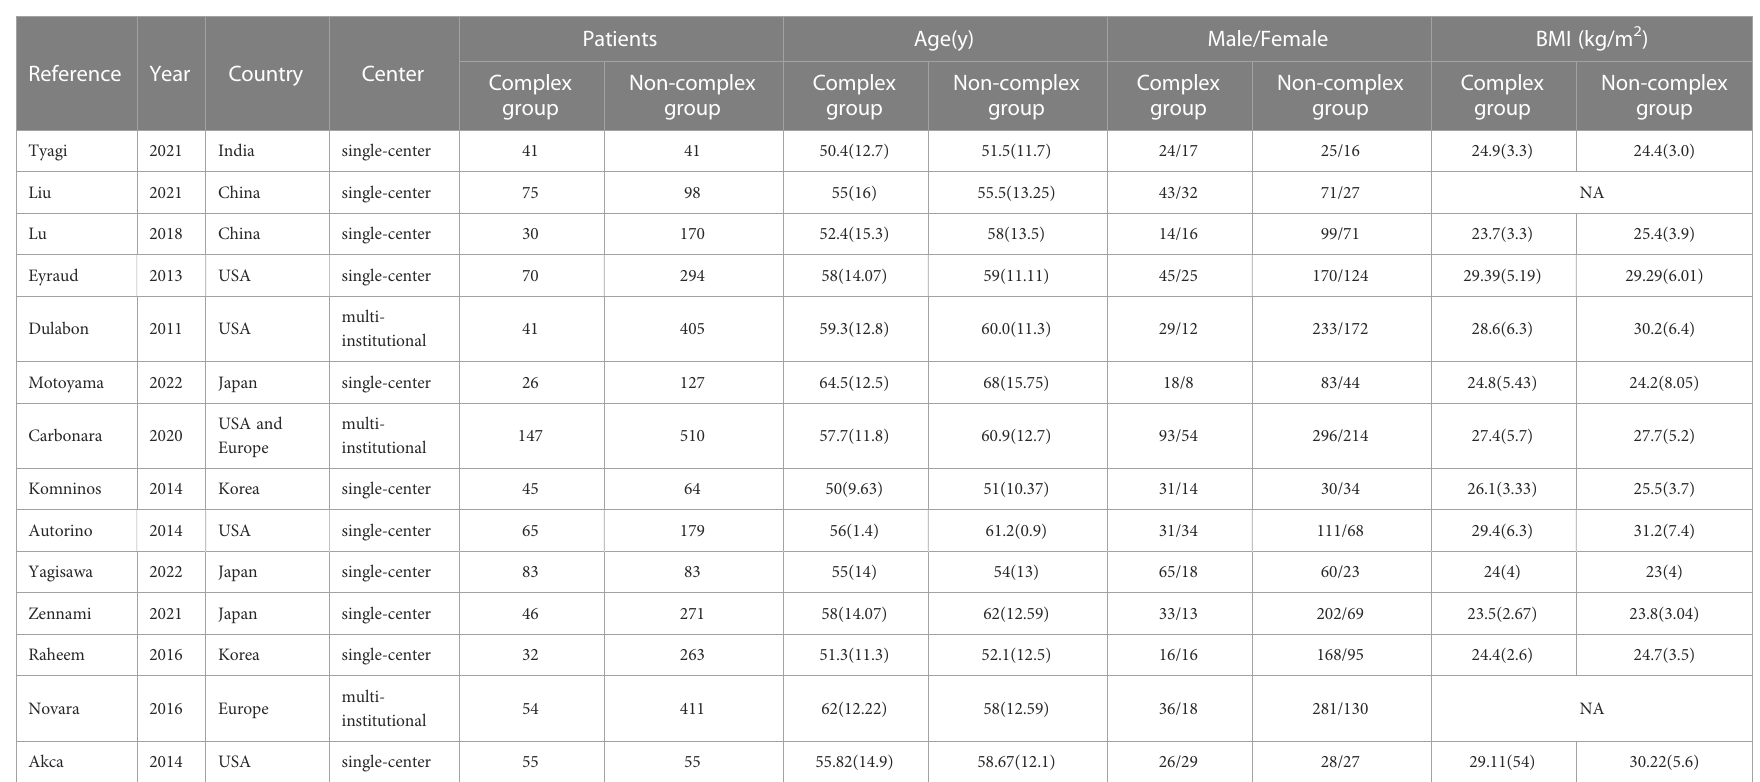
TABLE 1 The trials included in the systemic